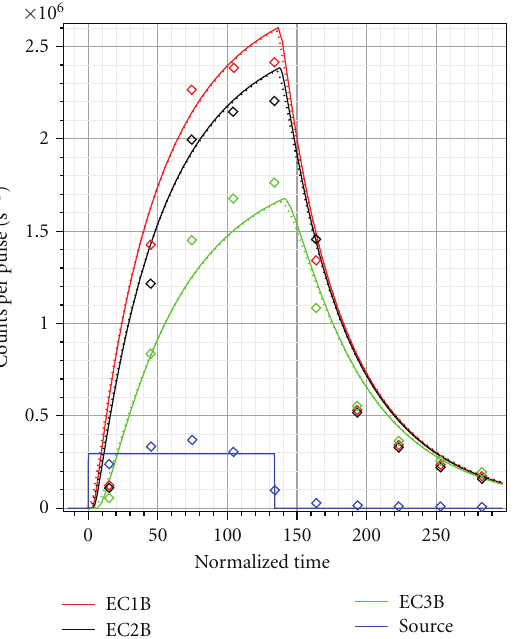
Figure 8: Comparison of the analytical results for the space-time dependent neutron flux (full line— P 1 transport; dotted line— di ff usion) with the results for the SC3A experiment at the YALINA- Booster facility on linear